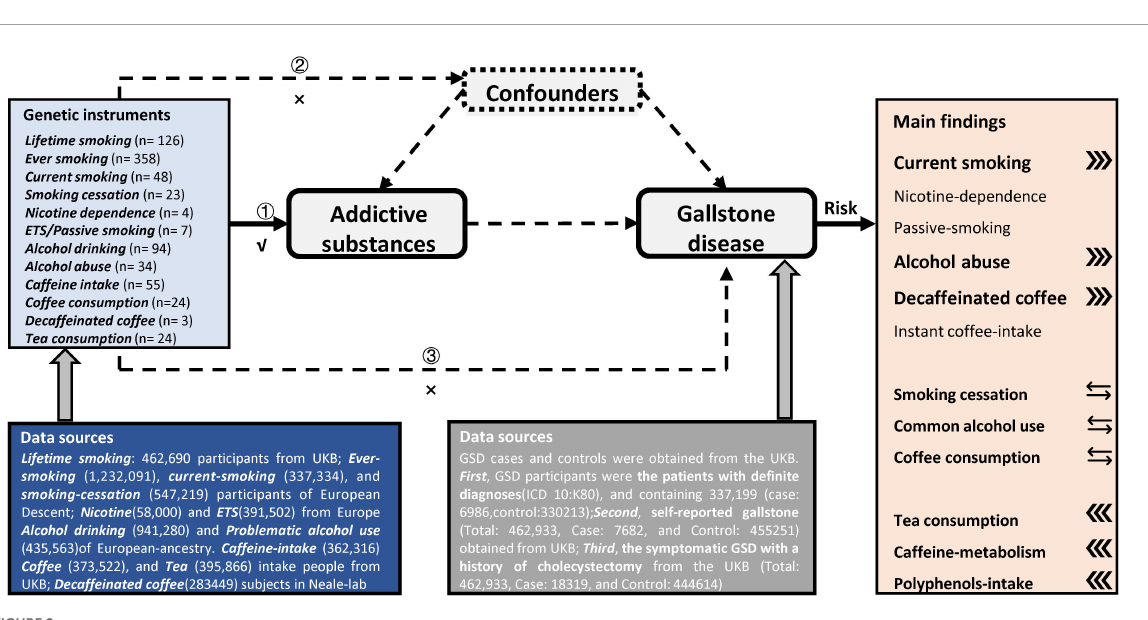
FIGURE2 Overview of the design and main findings in this Mendelian-randomization study. Assumption 1 indicates that the genetic instruments are significantly genome-wide associated with these addictive substances of interest. Assumption 2 indicates that our genetic instruments should not be associated with confounders. Assumption 3 indicates that genetic instrument affect these outcomes only via the